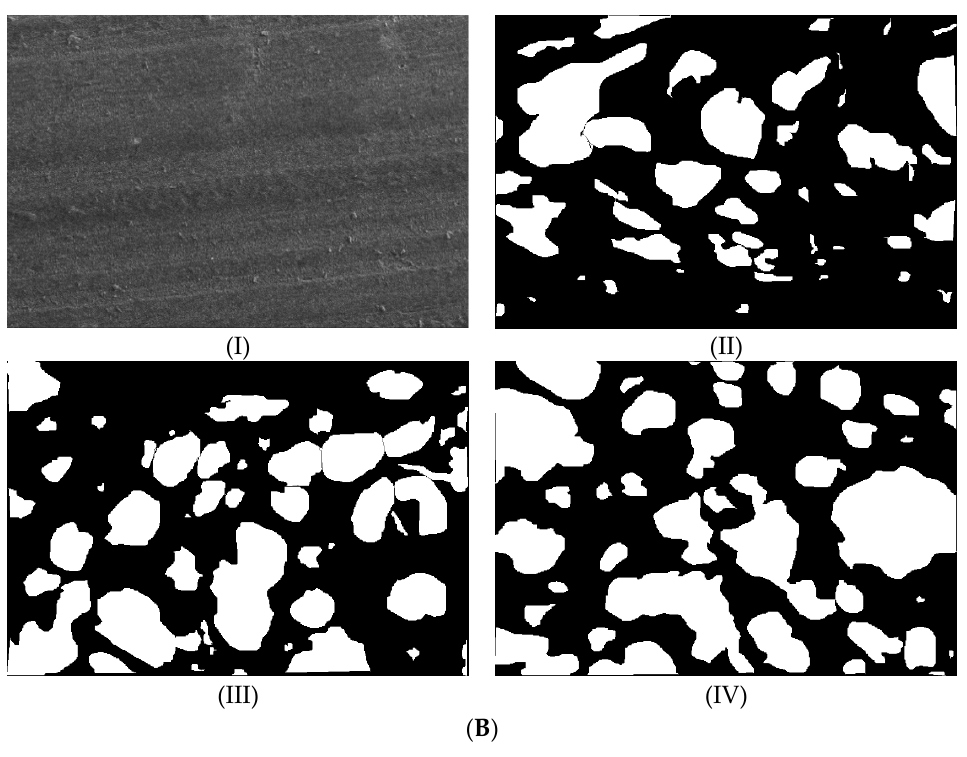
Figure 11. ( A ) SEM photos of different specimens, and ( B ) images processed using image processing.